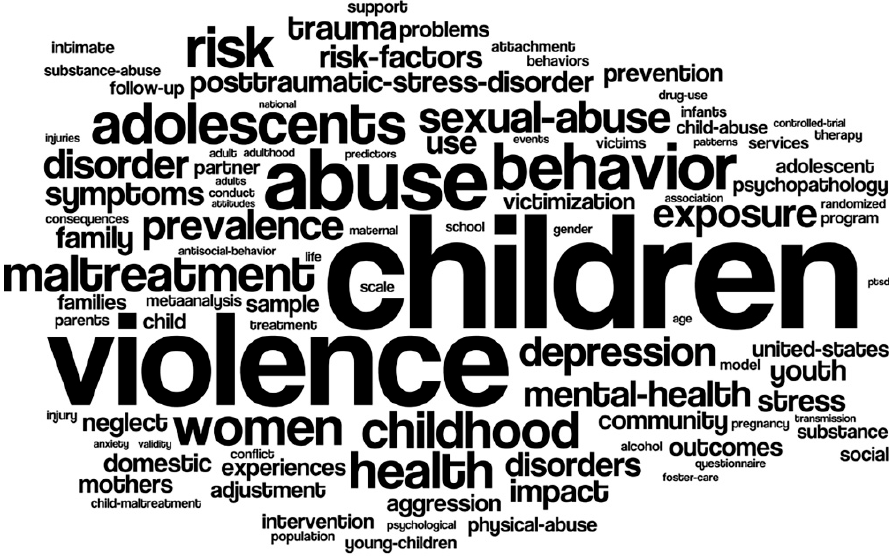
Figure 2. A global network of the most prolific countries (more than 50 papers). Note: America = Red; Europe = Green; Blue = Australia; Asia = Yellow, Africa & Middle East = Yellow.